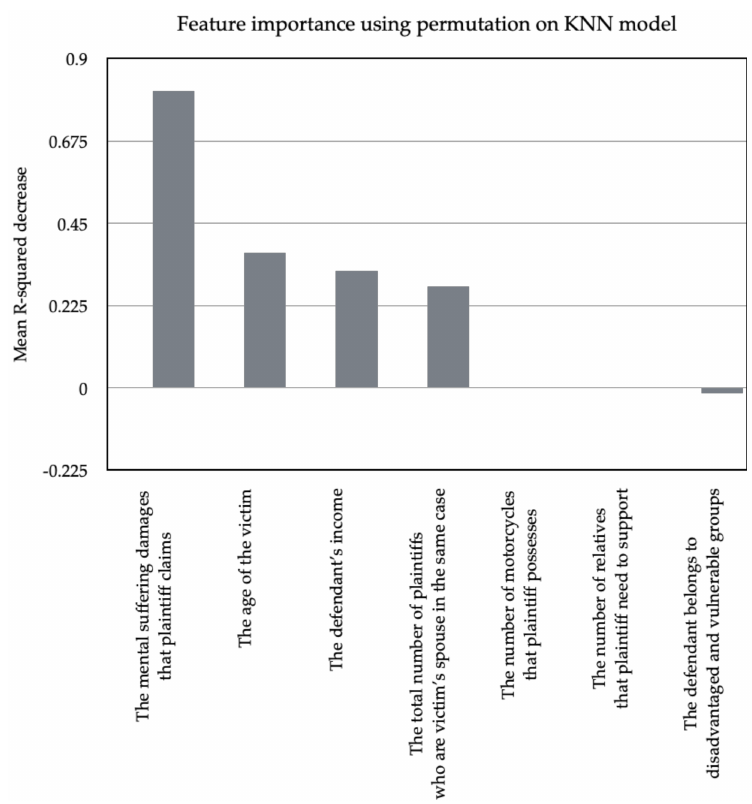
Figure 2. Feature importance using permutation on the KNN model.